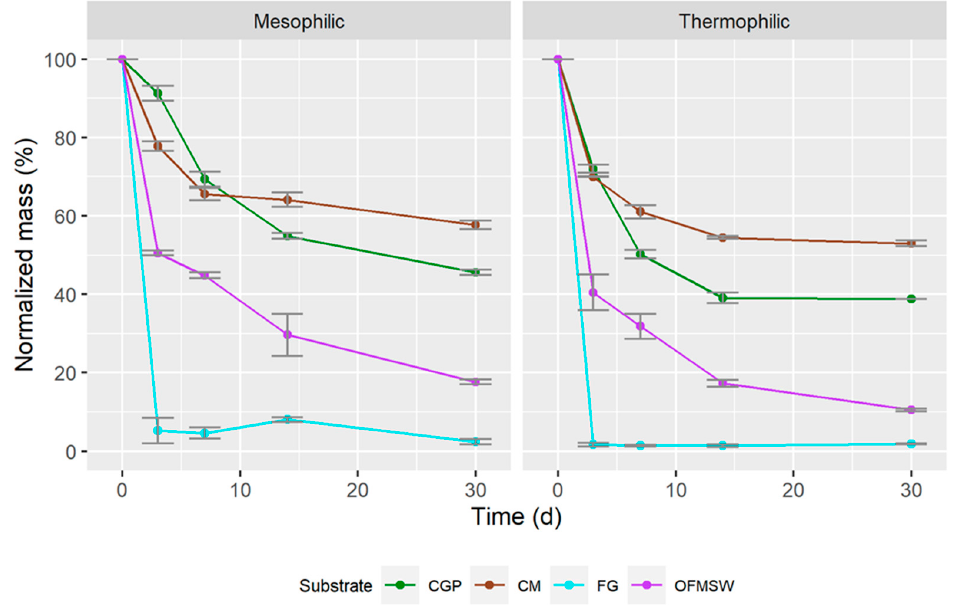
Figure 4. Total mass remaining in Dacron bags over time in continuous experiment. Two different conditions (mesophilic, left and thermophilic, right) are shown with four different substrates. Substrates used are clover grass pulp (green), cattle manure (brown), Fertigro ® (blue) and organic fraction municipal solid waste (purple). Error bars show standard deviation ( n = 3).